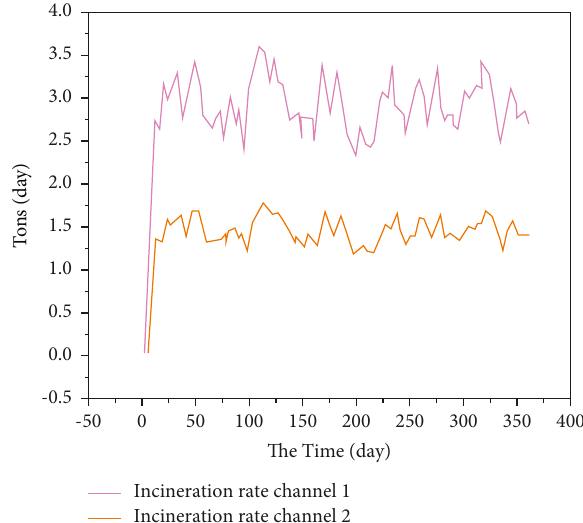
Figure 14: Comparison of incineration rates of nonreusable wastes.